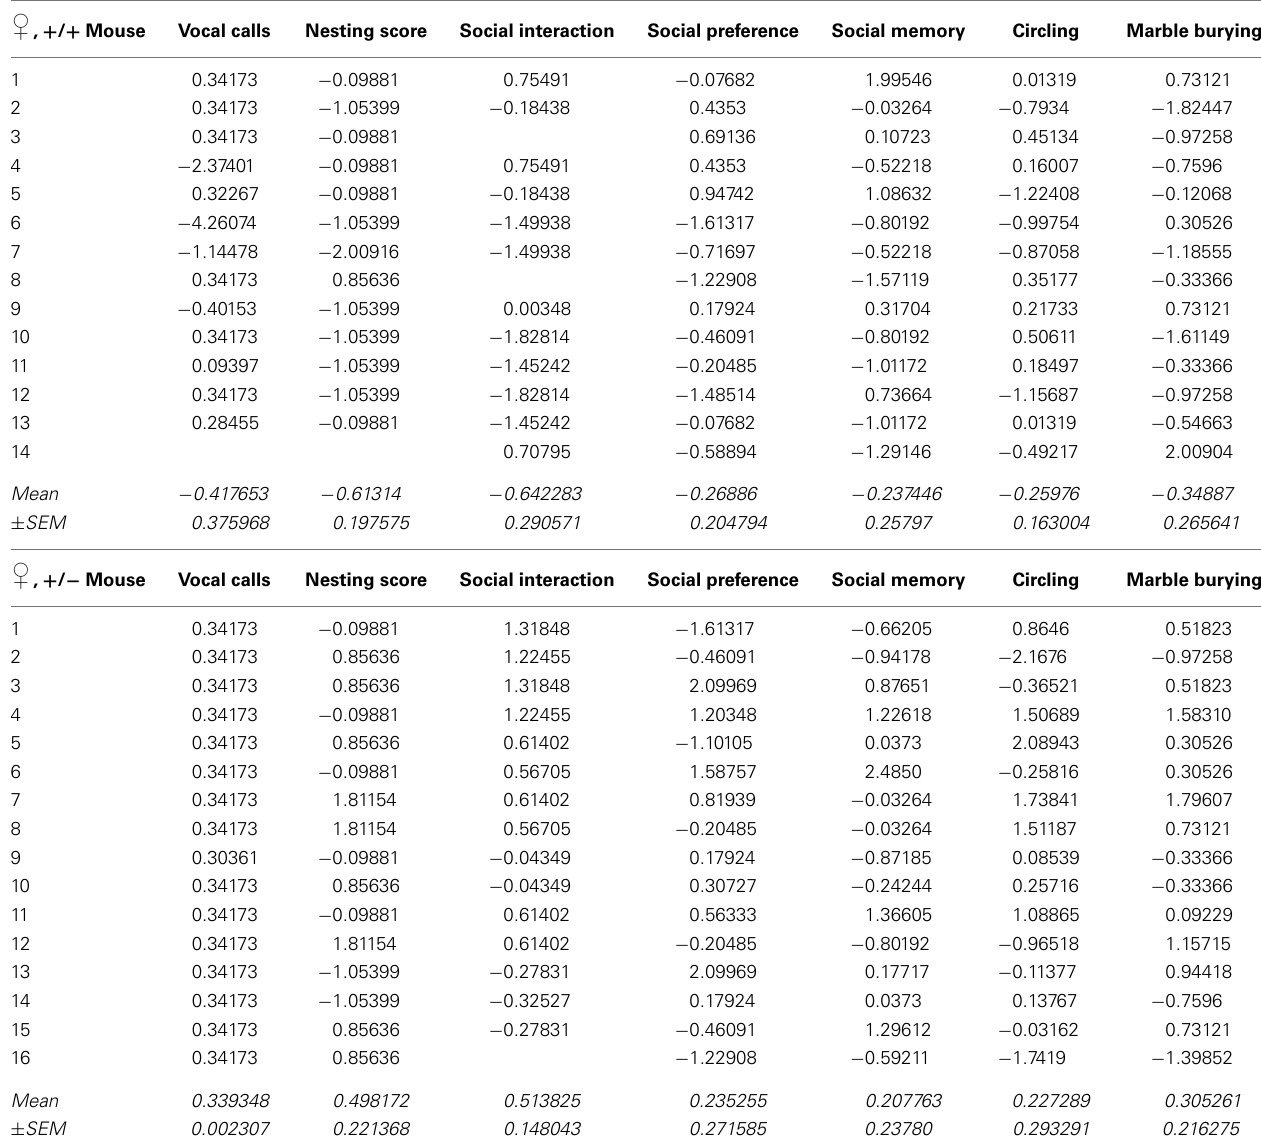
Table 1 | Individual z -standardized values for single readouts of the autism composite score of female Ambra1 + / + and Ambra1 + / − mice (see Figure 7)